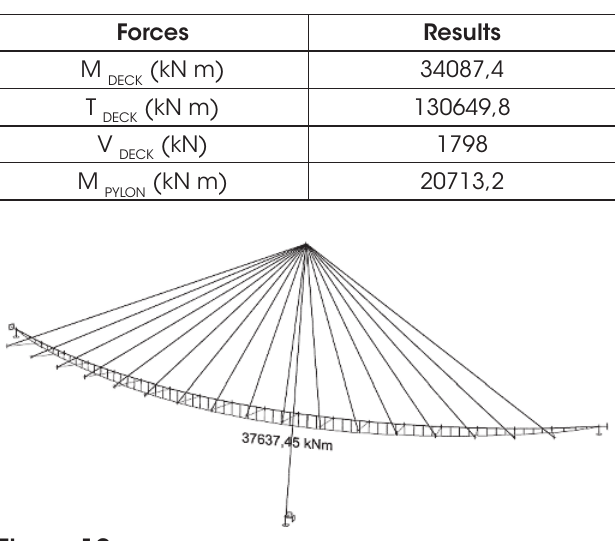
Moments and shear force summary in curved deck: suspension by inner side